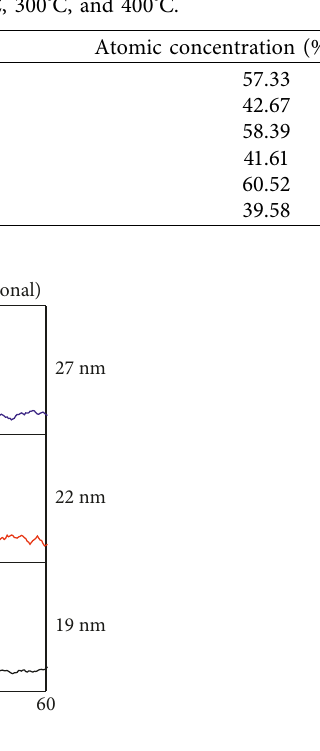
Figure 6: XRD patterns of NiS thin films obtained from the spin-coating method at 200 ° C, 300 ° C, and 400 ° C (crystallite sizes are shown on the side).